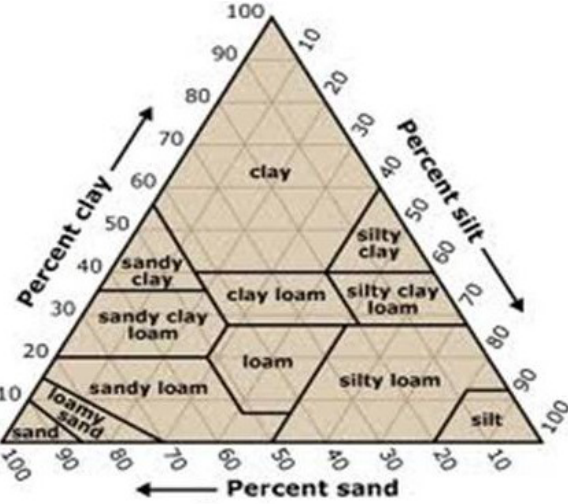
Fig. 1. Sand/clay/silt triangle of texture composition according USDA (1998). 3